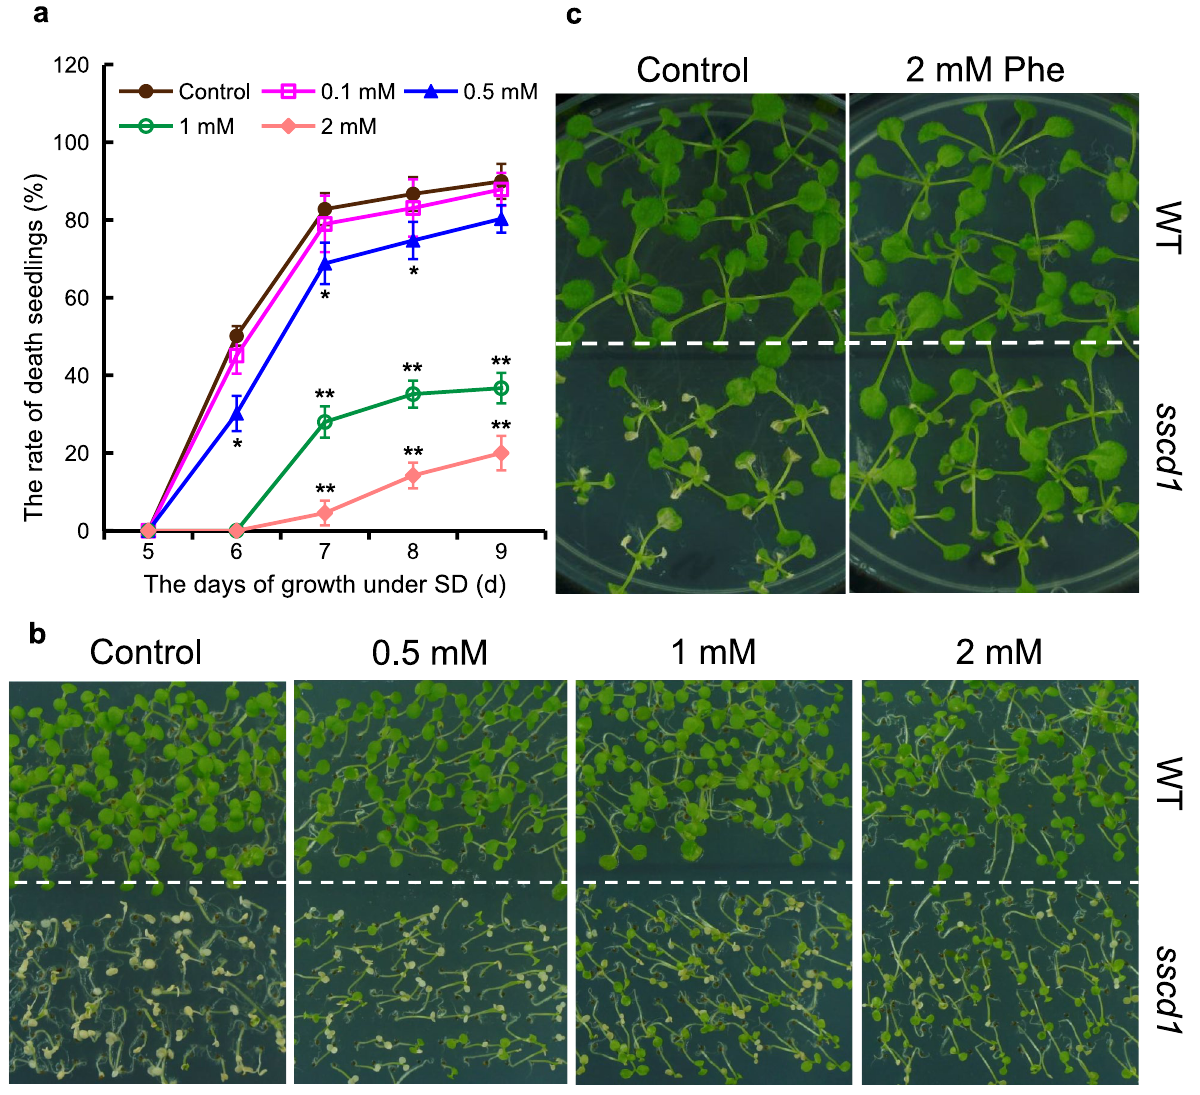
Figure 1. The death of sscd1 seedlings was suppressed by treatment with Phe. ( a ) The death rate of sscd1 seedlings which were grown in medium added without (control) or with 0.1, 0.5, 1, or 2 mM Phe under SD for 5–9 days. Error bars represent standard deviations (n > 30). The experiment was performed in three independent biological repeats. The single asterisk and double asterisks represent the significance of differences compared to the control (two-tailed Student’s t-test) at the level of P < 0.05 and P < 0.01, respectively. ( b ) The phenotype of WT and sscd1 seedlings which were grown in medium added without (control) or with 0.5, 1 or 2 mM Phe under SD for 7 days. ( c ) The phenotype of WT and sscd1 seedlings which were first grown in MS medium under LD for 7 days and transplanted to MS medium added without (control) or with 2 mM Phe for an additional 7-d growth under LD, and then transferred to SD for a 7-day growth. Phe phenylalanine; SD short day; WT wild type, Col-0; LD long